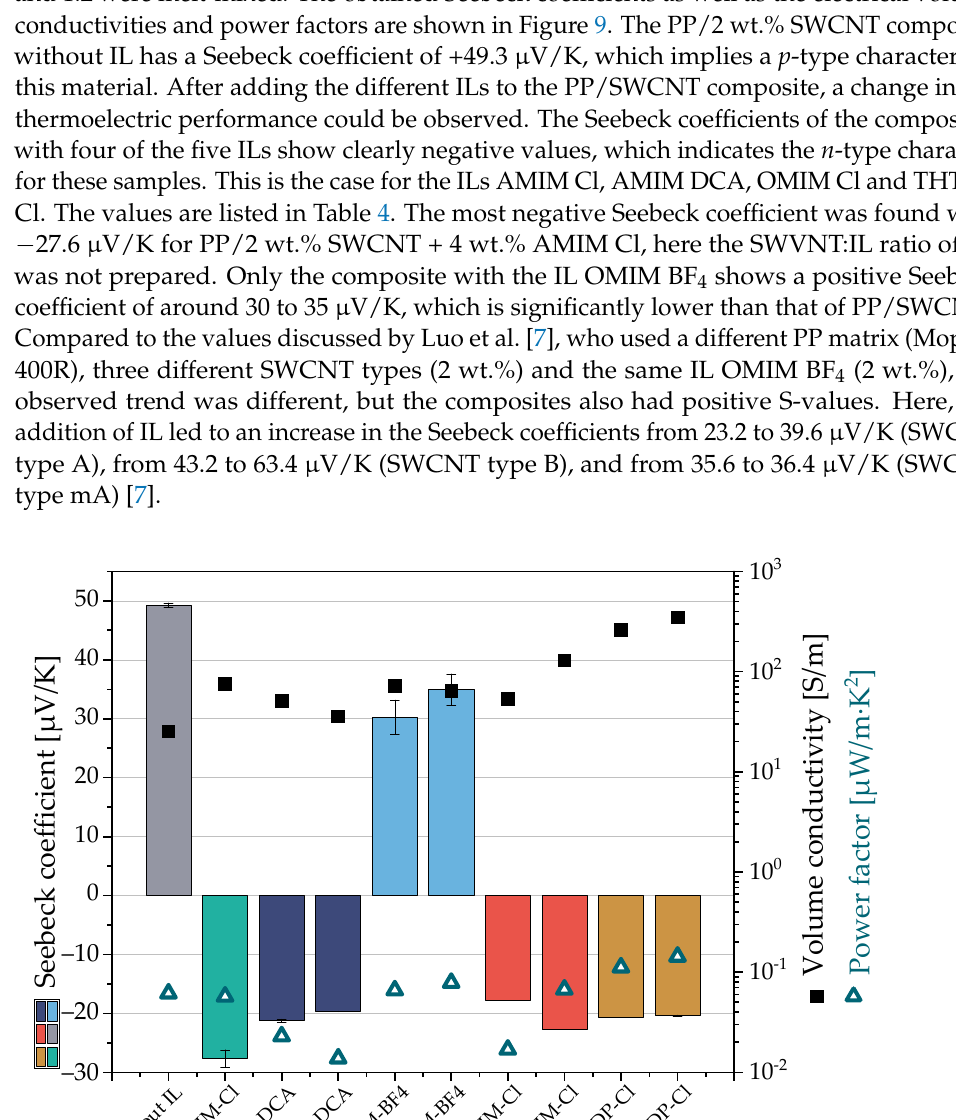
Figure of Merit ZT [-]